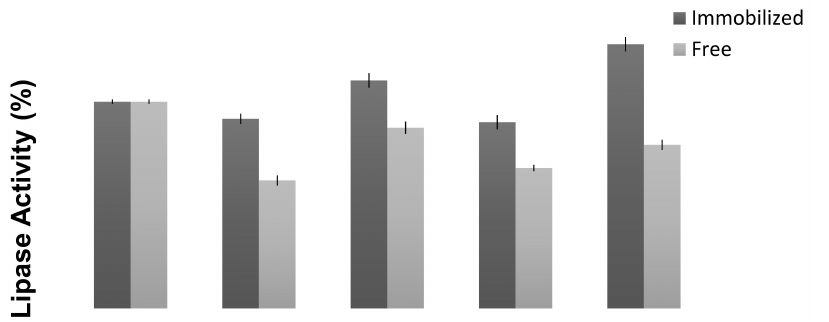
Figure 5. Effect of substrate type on free and CaCO 3 -immobilized lipase activity. Hydrolysis was conducted at pH 12 and 60 ◦ C. Data are expressed as the mean ± standard deviation of triplicate measurements.